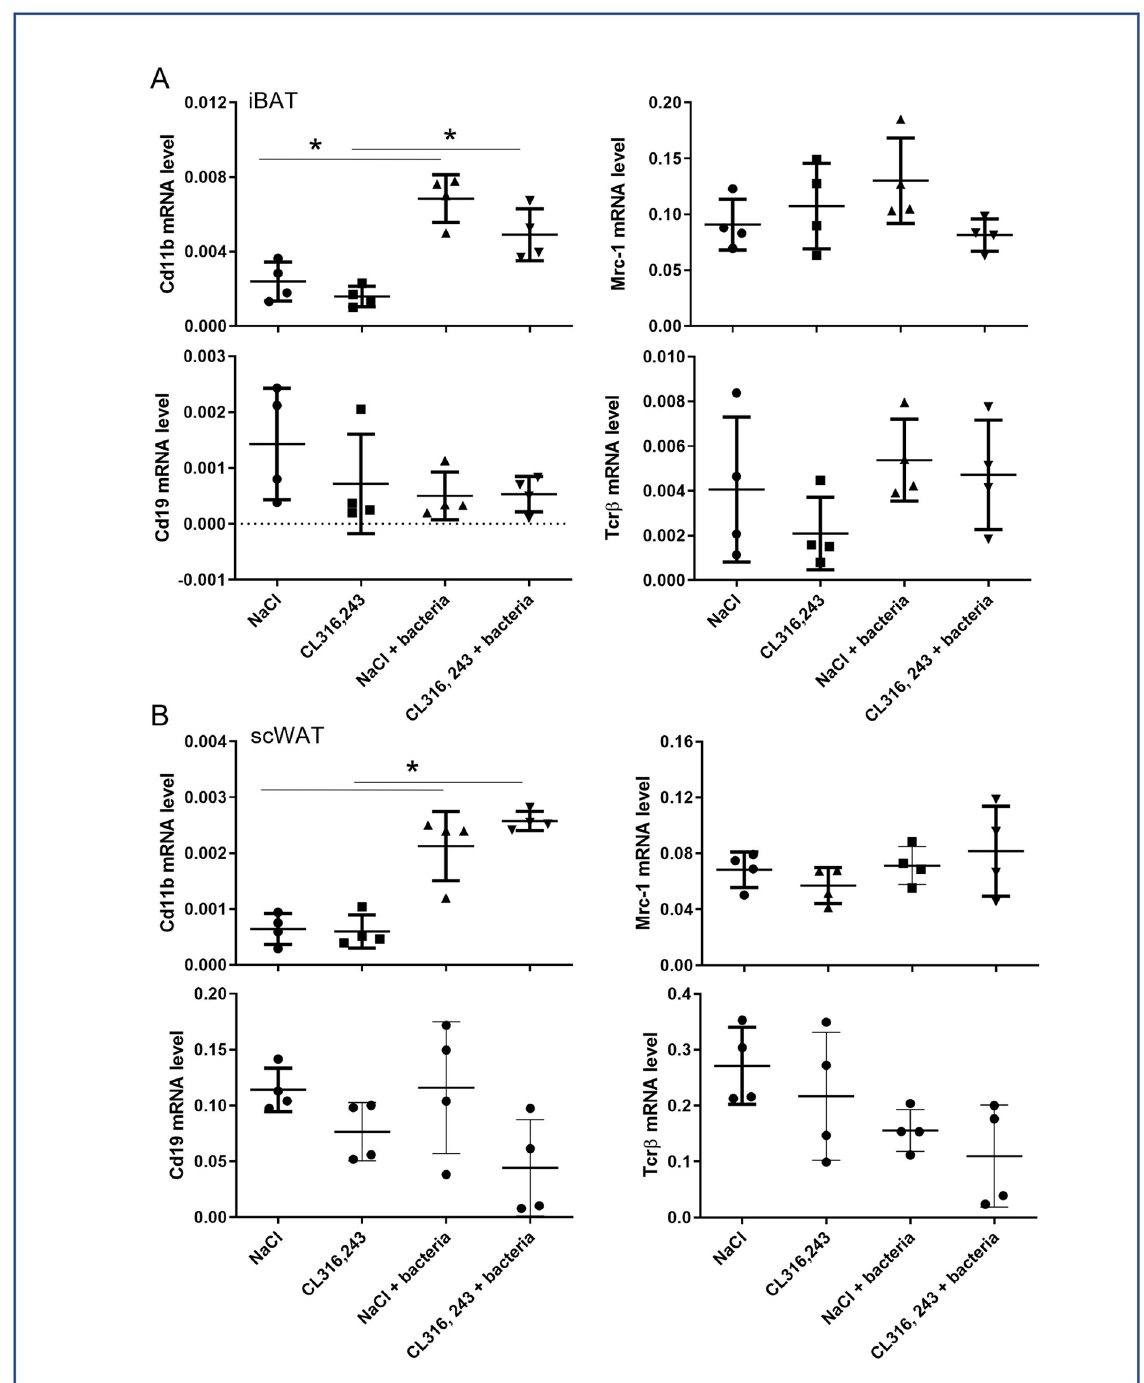
Fig 7. Effect of CL316,243 and bacteria on mRNA of immune cell markers. mRNA expressions of monocyte/macrophage (Cd11b), anti- inflammatory macrophage (Mrc-1), T (Tcr β ) and B (Cd19) lymphocytes were analysed by qPCR in iBAT and scWAT from mice that were treated for 1 week with CL316,243 daily (1 mg/kg/day) or vehicle only (NaCl), and then infected or not with E . coli for 48 hours. The results are displayed as independent values (dots) and the mean ± SD. n = 4. � p < 0.05.